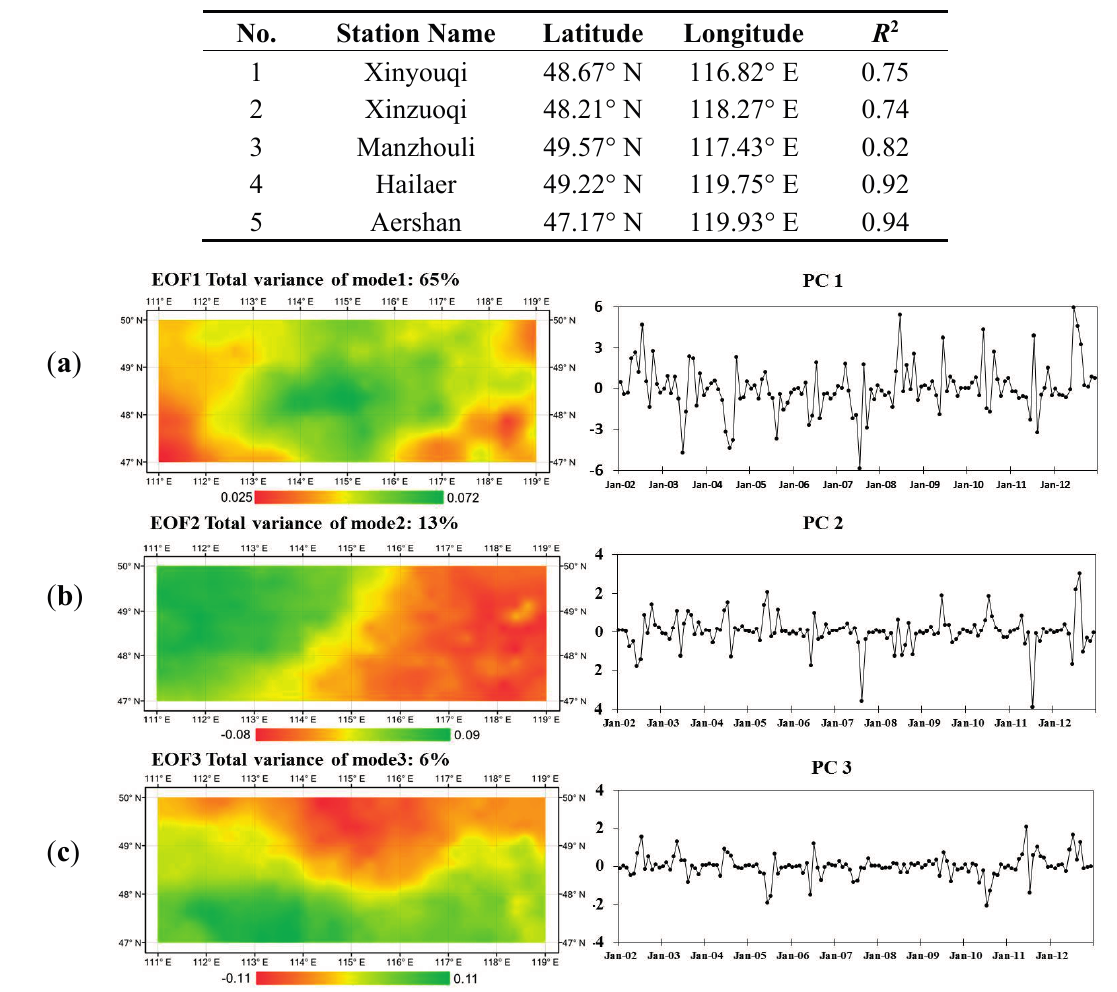
Figure 3. EOF decomposition of precipitation changes derived from TRMM satellite data over study area. EOF patterns are shown in left side and corresponding unit-less temporal patterns (PCs) in right side. ( a ): The first change mode of precipitation changes; ( b ): The second change mode of precipitation changes; ( c ): The third change mode of precipitation